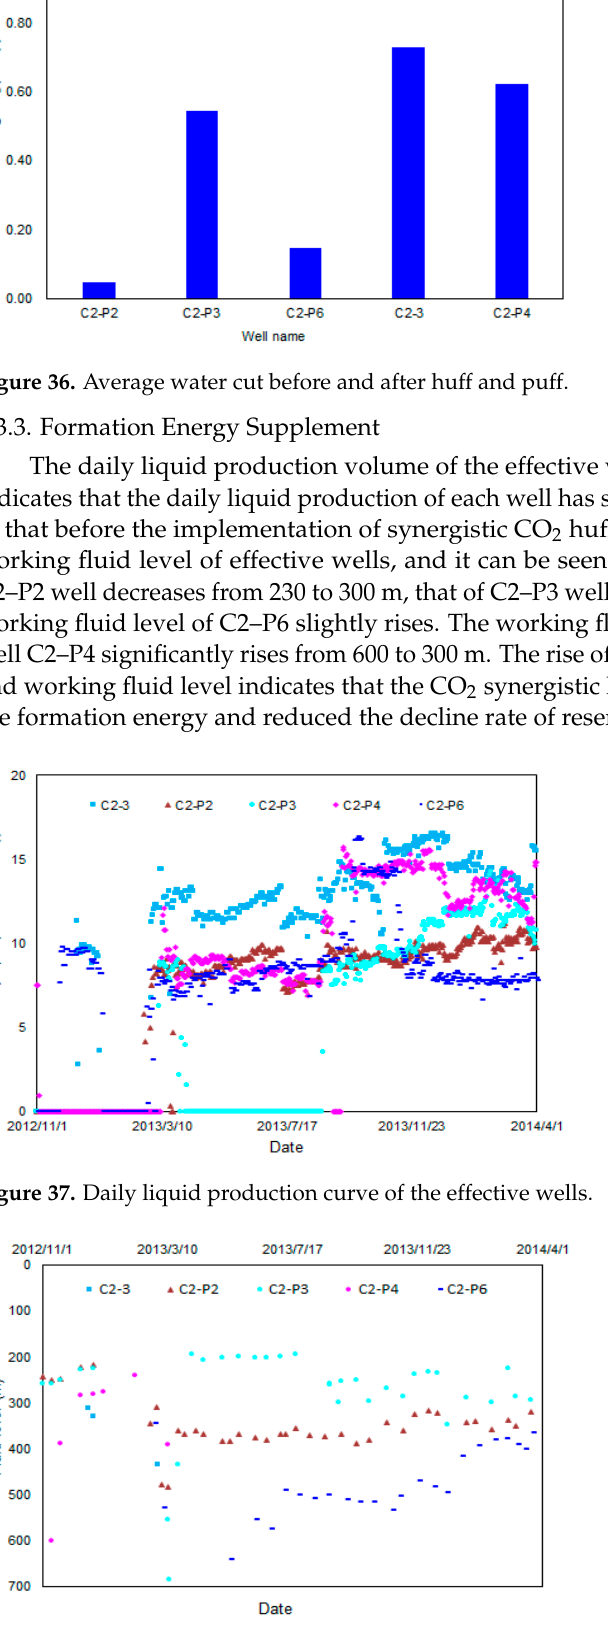
Figure 35. Water-cut curve of effective wells .